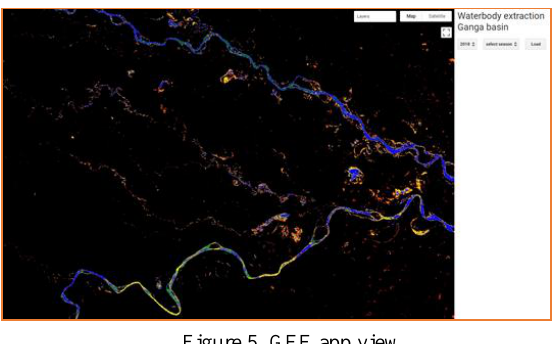
Figure 5. GEE app